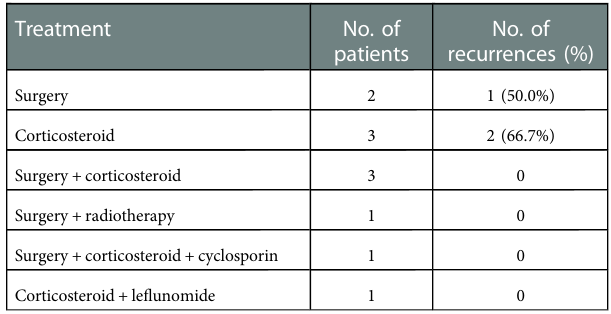
TABLE 3 Treatment modalities and recurrence